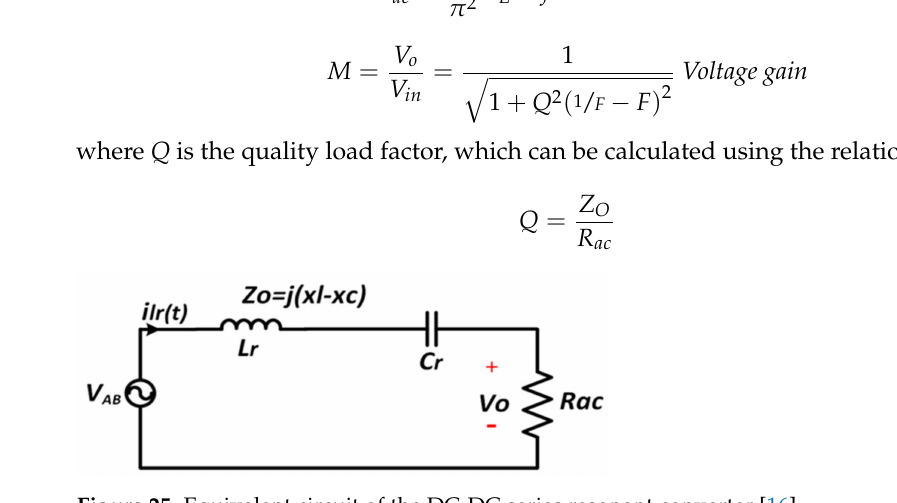
Figure 25. Equivalent circuit of the DC-DC series resonant converter